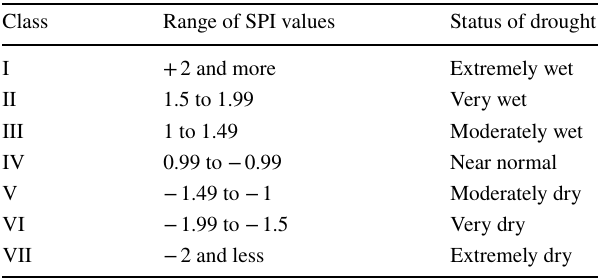
Table 1 Classification of drought intensity due to SPI